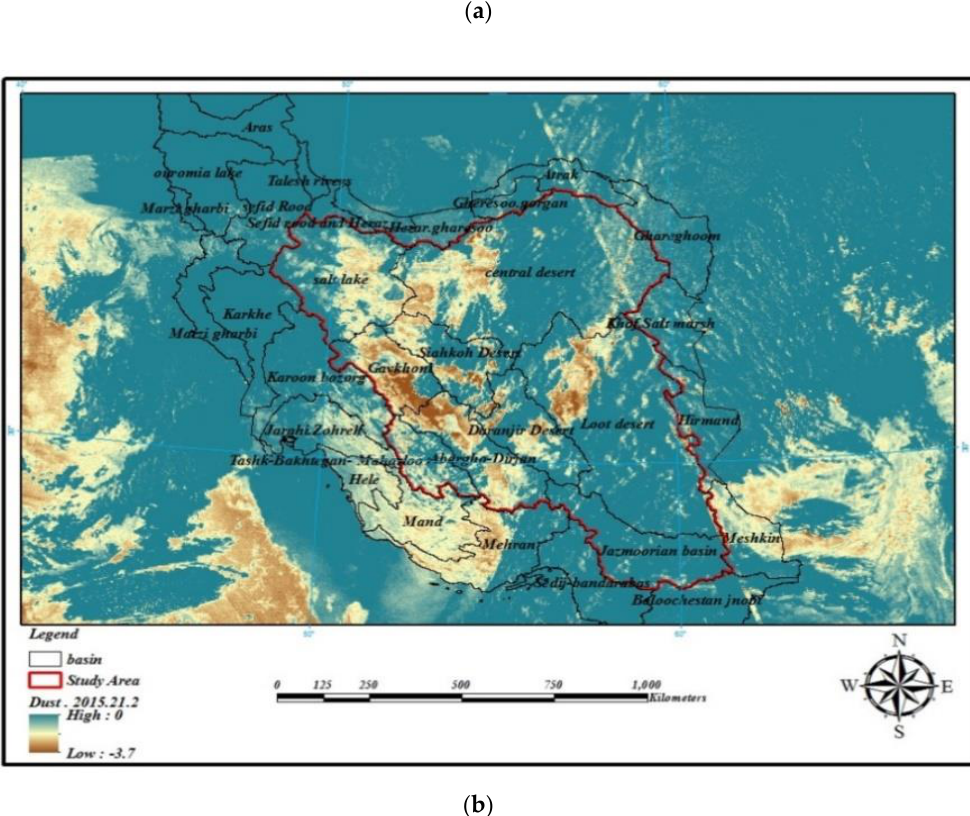
Figure 4. Ackerman Index of Moderate Resolution Imaging Spectroradiometer (MODIS) images of Dust storm on 09:00 UTC, 21 February 2015 ( a ) and 09:00 UTC, 14 February 2018 ( b ) by Ackerman Index.